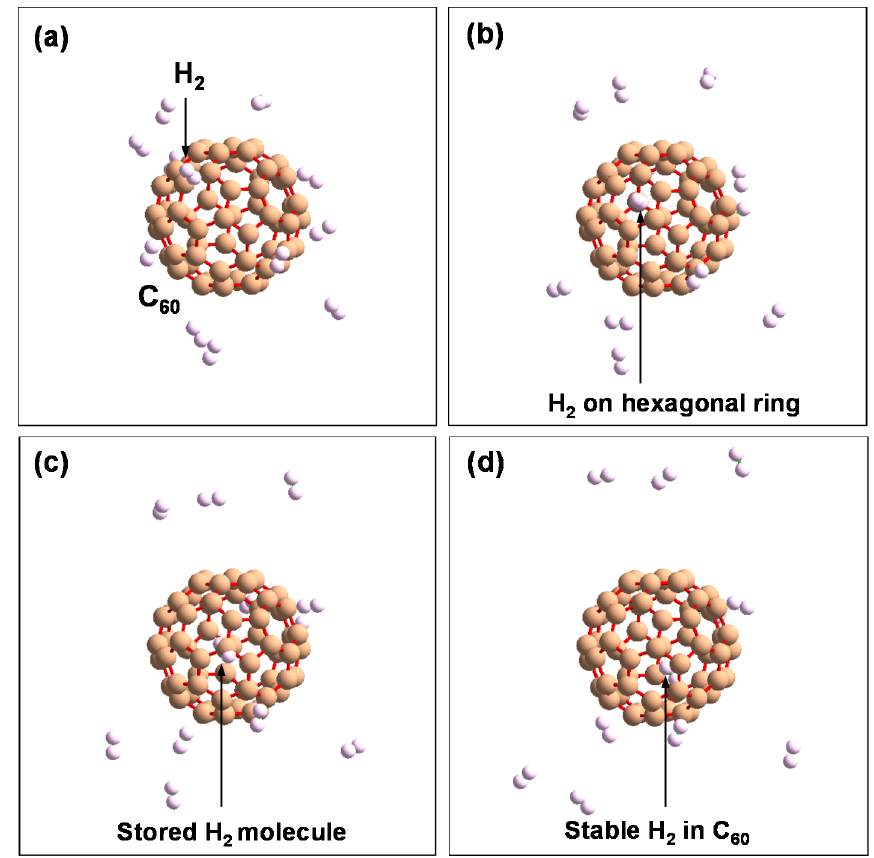
Figure 13. Schematic model of H 2 molecule stored in hexagonal ring in the order of ( a – d